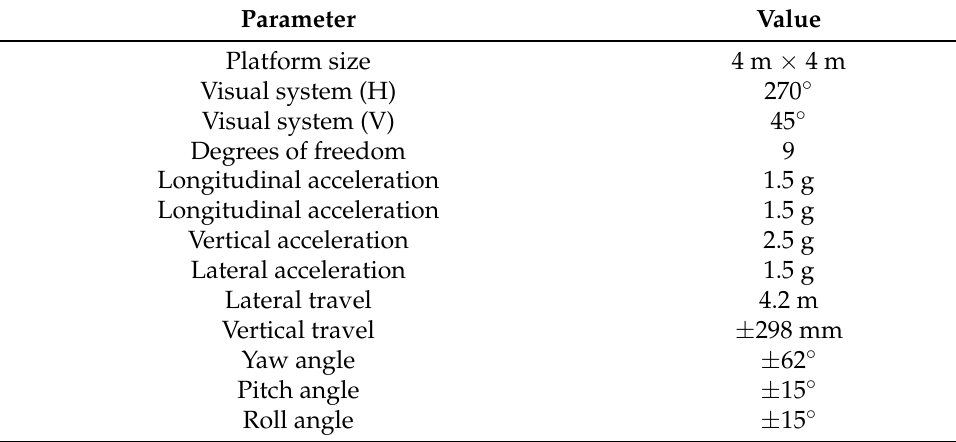
Table 3. Driving simulator DIM400